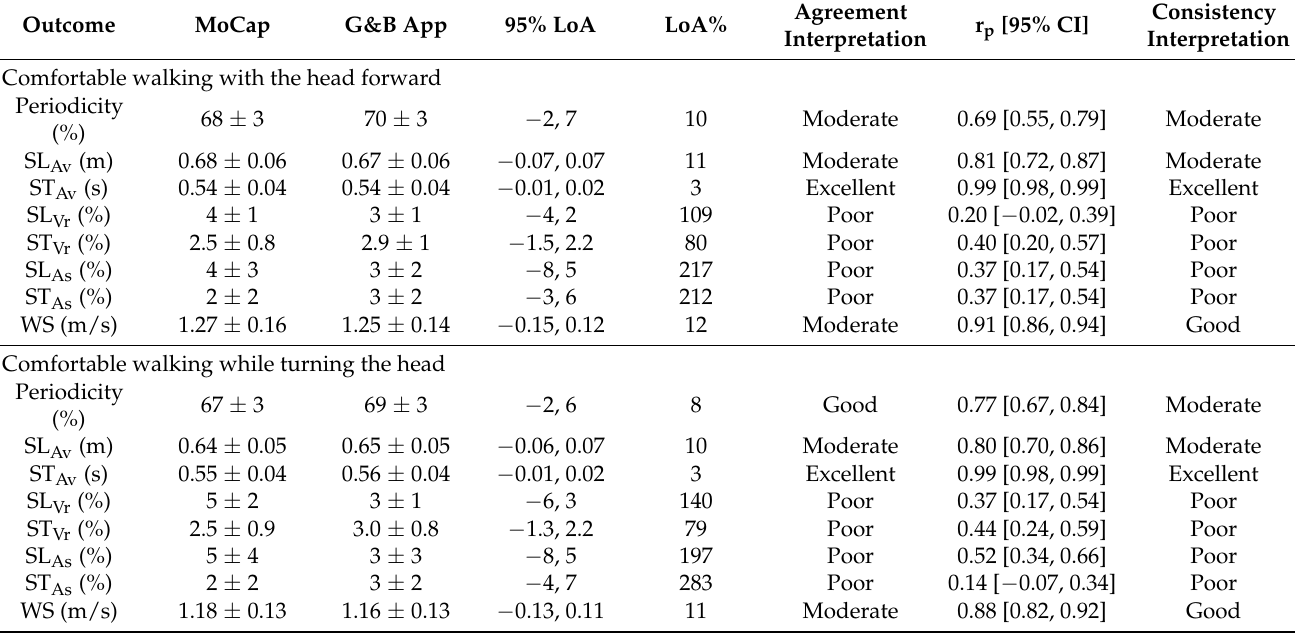
Table 2. Validity of gait outcomes obtained from the Gait&Balance (G&B) application compared to the 3D motion capture (MoCap)